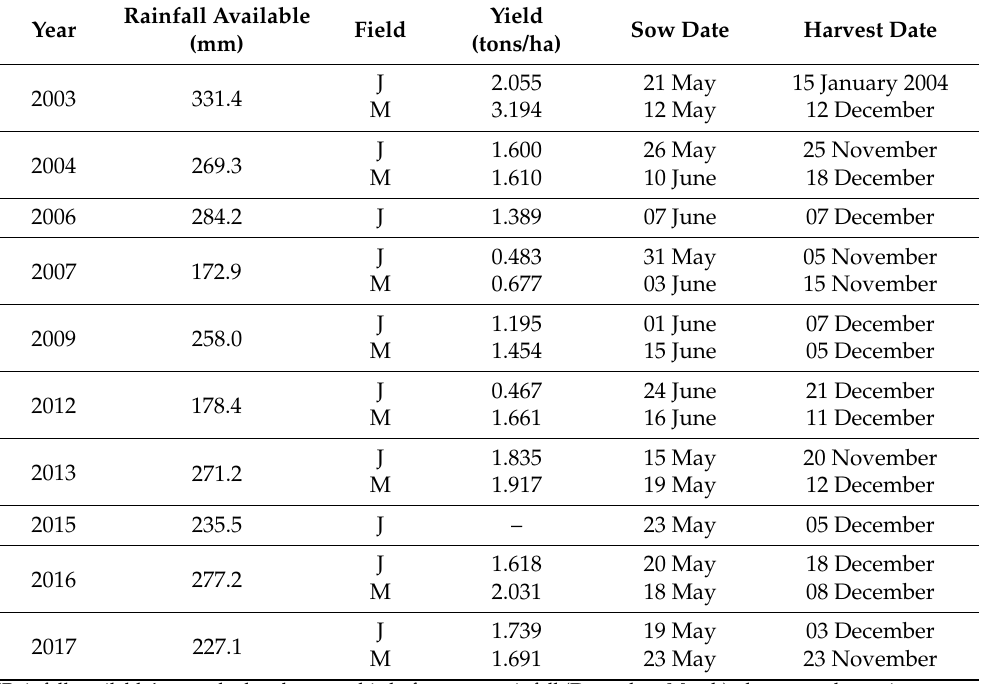
Table 1. Farming management and rainfall conditions for winter wheat in the two field sites during 2003 to 2017. Yield Rainfall Available Field Year (tons/ha) (mm) 2003